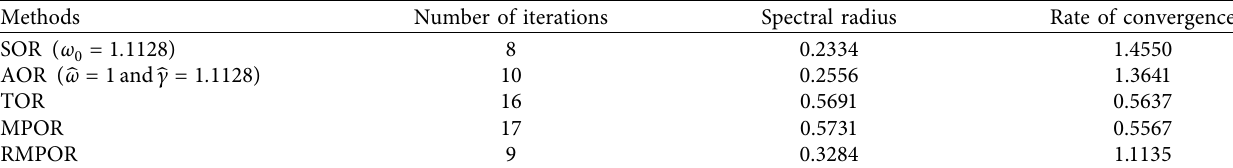
Table 1: Comparison of SOR, AOR, TOR, MPOR, and RMPOR methods for Example 1. Methods Number of iterations Spectral radius